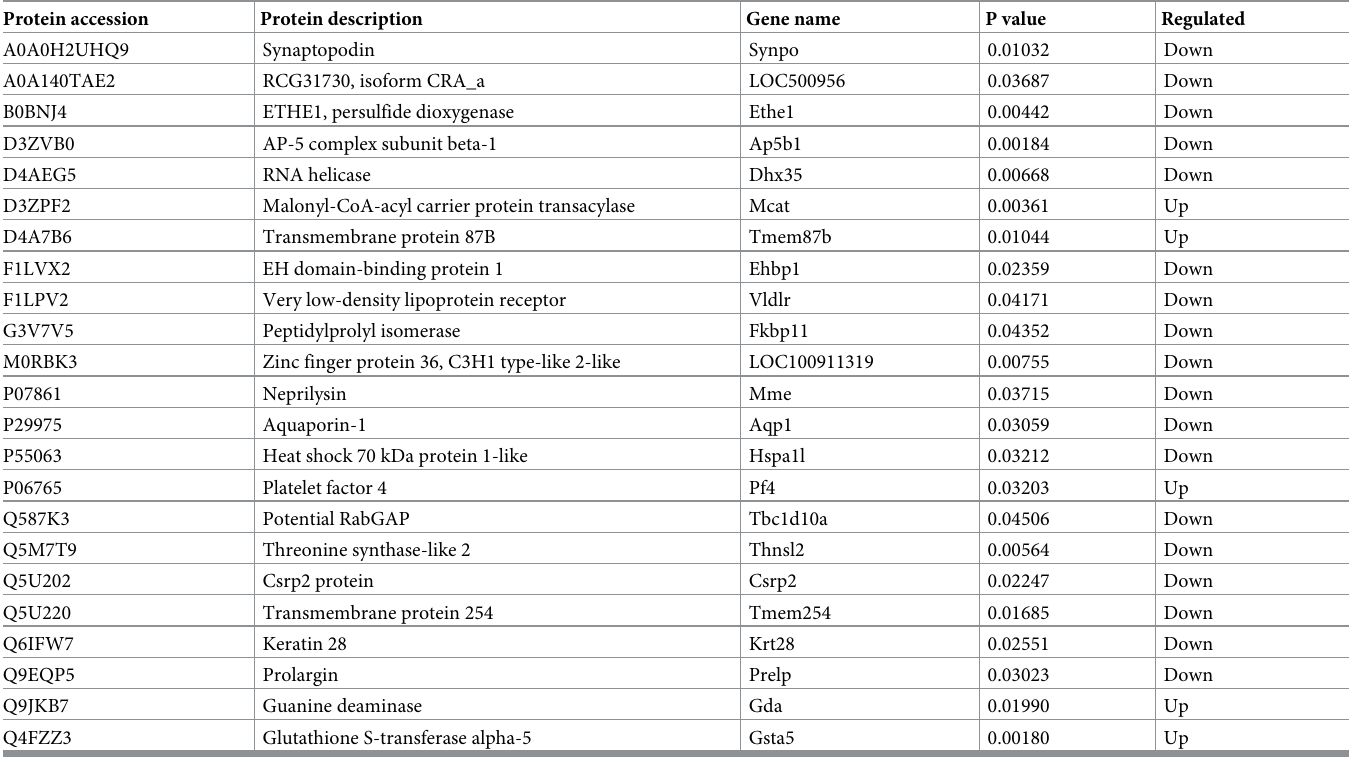
Table 1. Differentially expressed proteins in the placentas of the HFHS+STZ and NC groups. Protein